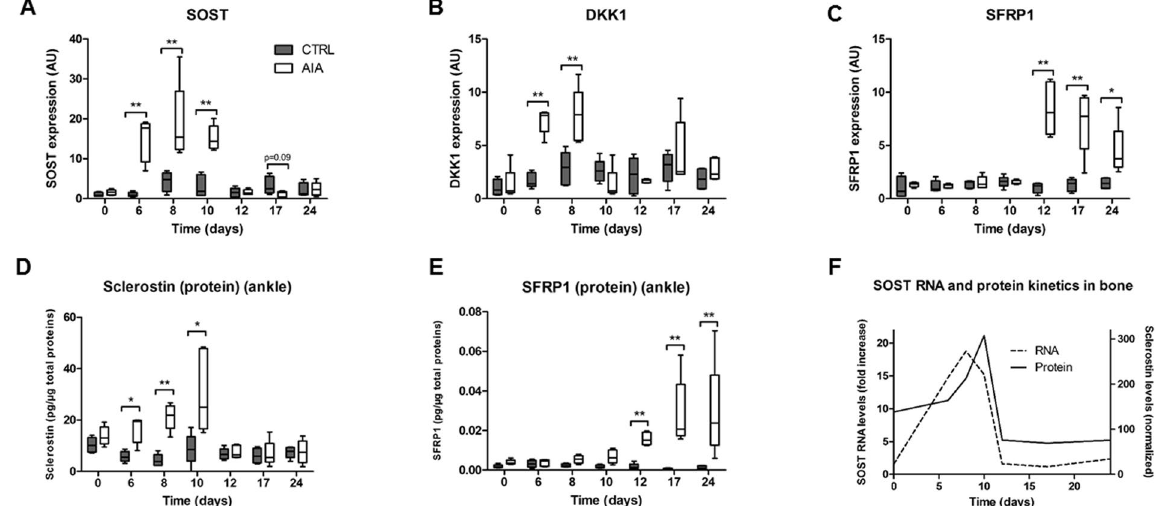
Figure 5. Early modifications in Wnt inhibitor expression. Quantitative RT-PCR for all 7 time points in ankle: ( A ) SOST, ( B ) DKK1, and ( C ) SFRP1. Protein assay in ankle at all 7 time points for ( D ) sclerostin and ( E ) SFRP1. Wnt inhibitors levels were normalized by total protein levels detected at the ankle site. ( F ) Timely comparison between SOST RNA and sclerostin protein levels in the ankle joint. Gene expression was normalized with housekeeping gene hypoxanthine-guanine phosphoribosyltransferase and CTRL group expression at baseline was set at 1. Boxes and bars were median ± interquartile range. AU: arbitrary units;